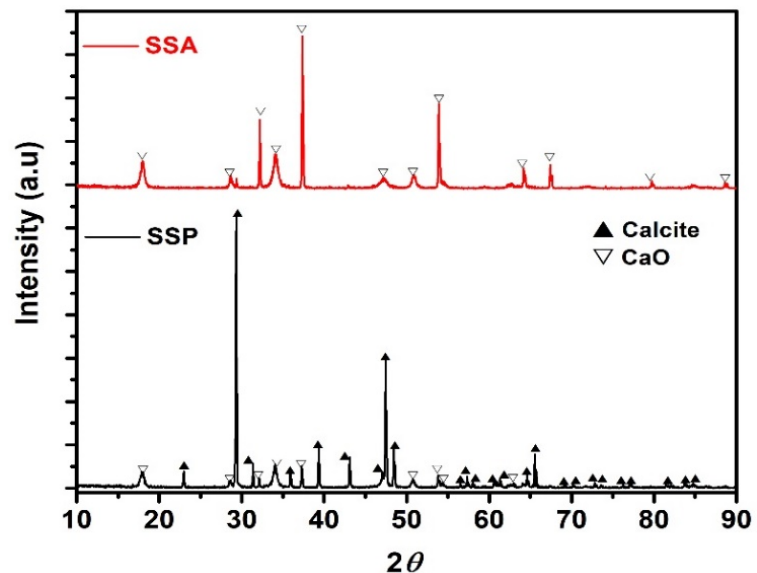
Figure 2. XRD pattern of SSP and